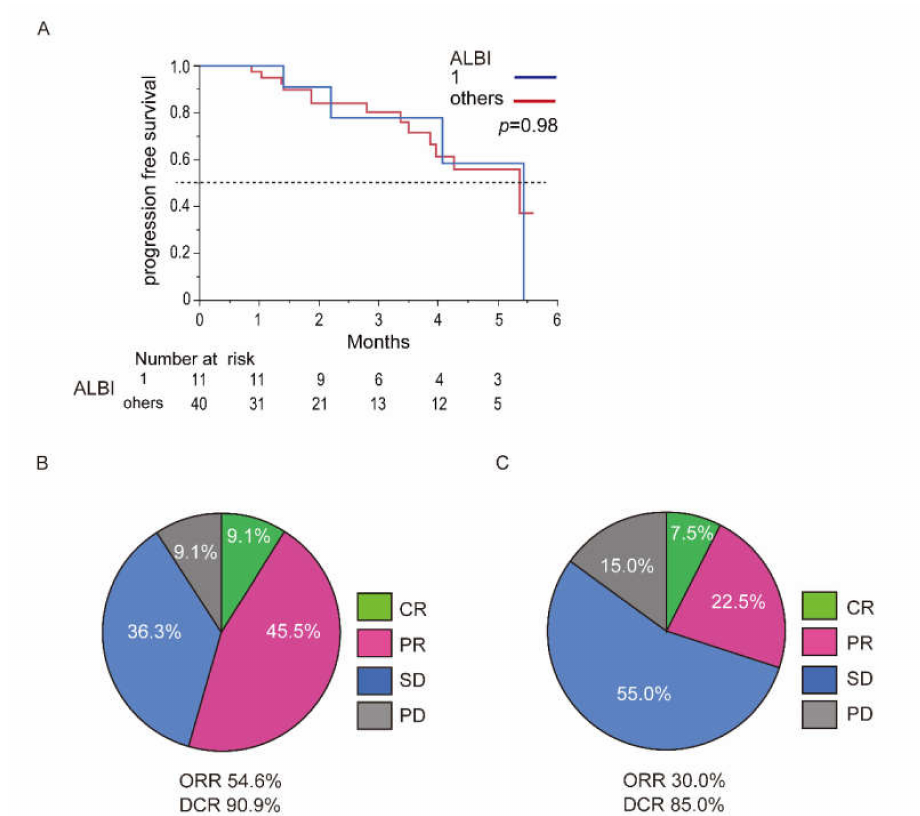
Figure 4. Difference of PFS and therapeutic response of atezolizumab plus bevacizumab between ALBI 1 and the others (ALBI 2 and 3). ( A ) The PFS curves of the ALBI 1 and the others (ALBI 2 and 3) patients treated with atezolizumab plus bevacizumab. The blue line expresses the ALBI 1 patient. The red line expresses the ALBI grade 2 and 3 patients. ( B ) Assessment of the therapeutic response in the ALBI 1 patients. Modified RECIST is used for assessment. ( C ) Assessment of the therapeutic response in the ALBI other patients. Modified RECIST is used for assessment. Abbreviations: PFS, progression free survival; ALBI,